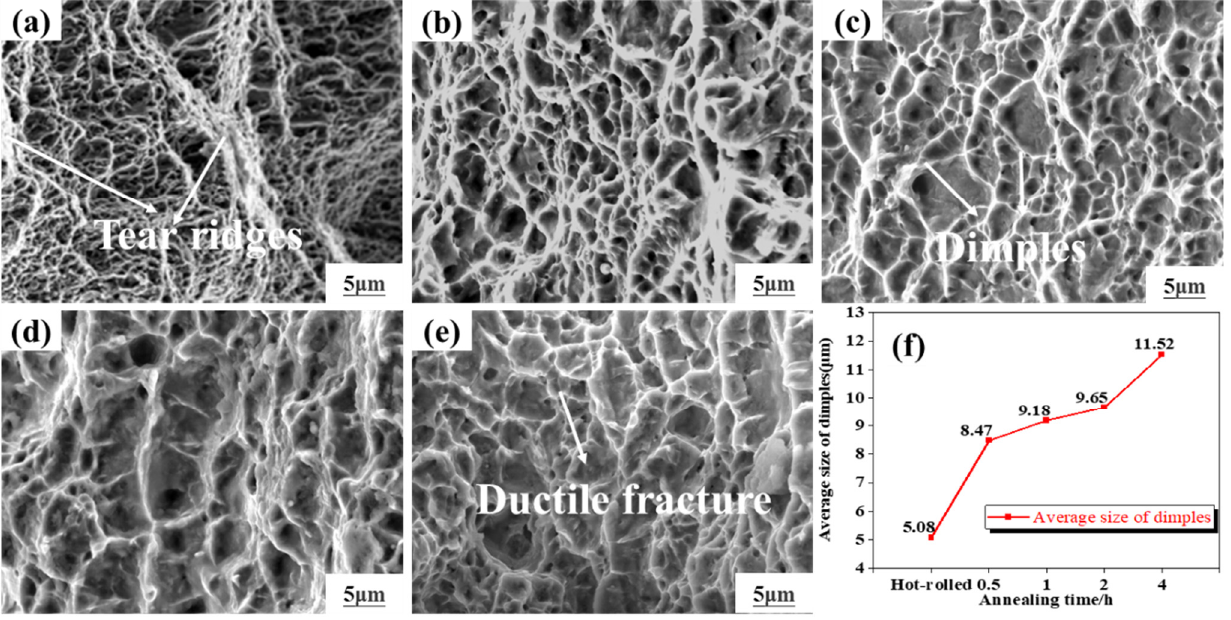
Figure 9. Fracture morphology of TA10 annealed sheets: ( a ) hot-rolled, ( b ) 0.5 h, ( c ) 1 h, ( d ) 2 h, ( e ) 4 h, and ( f ) average size of dimples.